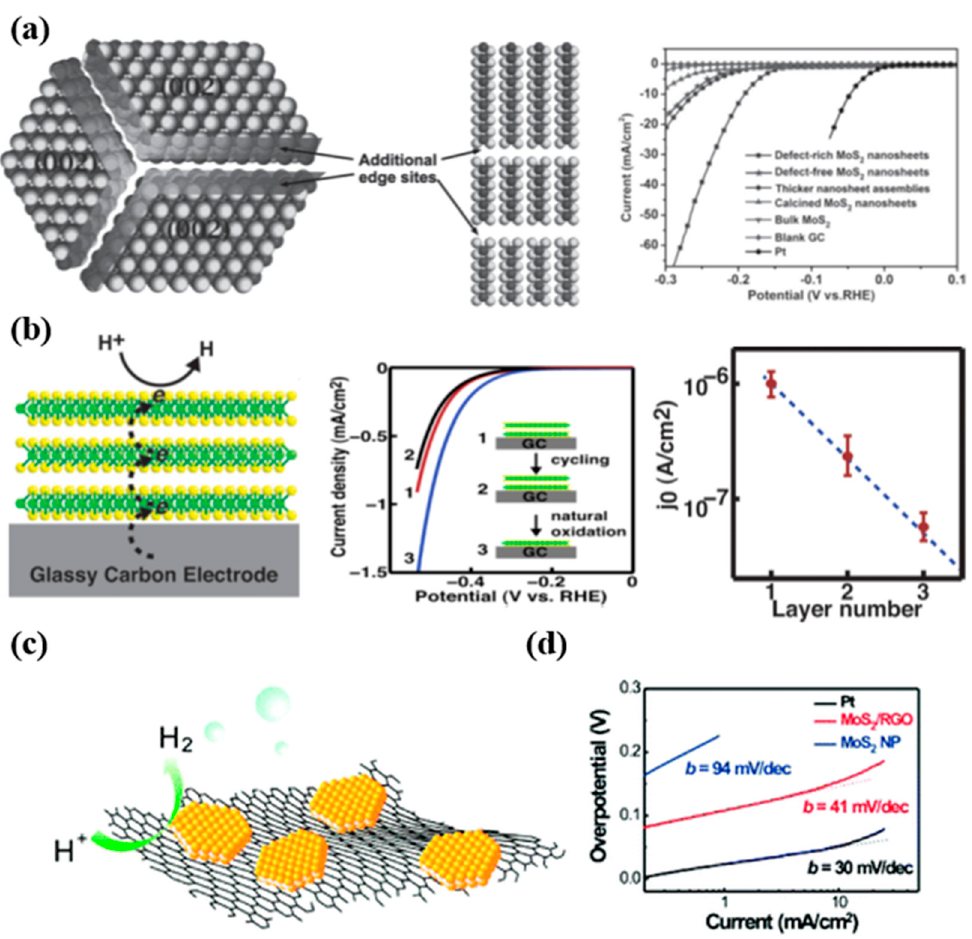
Figure 4. ( a ) Schematic representation of defect-rich MoS 2 nanosheets and polarization curves obtained from MoS 2 nanosheets with various densities of defects. Reprinted with permission from Reference [81], copyright (2013) Wiley-VCH. ( b ) Schematic illustrating the electron hopping between the layers of MoS 2 and evolution of the exchange current density of MoS 2 with increasing number of layers. Reprinted with permission from Reference [83], copyright (2014), American Chemical Society. ( c ) Illustration for the MoS 2 nanoparticles decoration on conductive graphene layer. ( d ) Tafel plots for the MoS 2 nanoparticles and MoS 2 nanoparticles decorated graphene samples along with Pt. Reprinted with permission from Reference [87], copyright (2011), American Chemical Society.